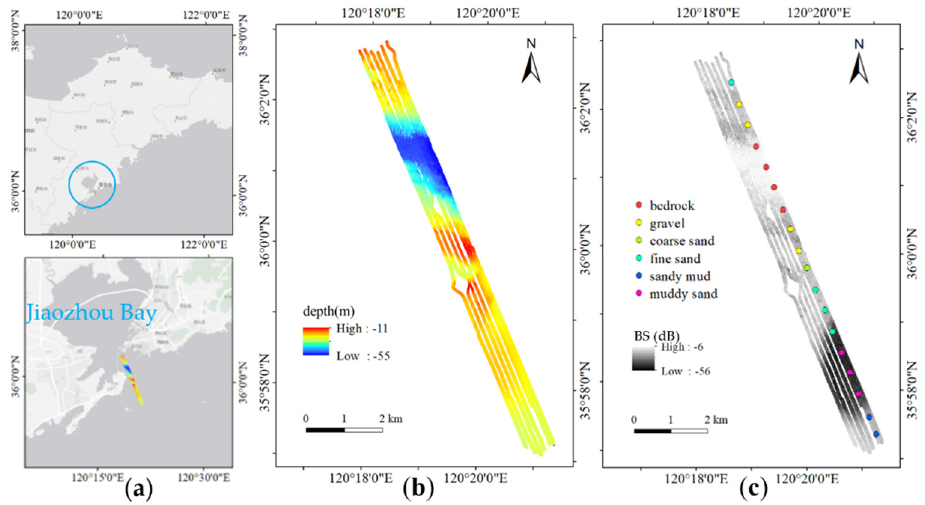
Figure5. ( a )Thelocationofthesurveyarea; ( b )seafloortopography; ( c Figure 5. ( a ) The location of the survey area; ( b ) seafloor topography ; ( c ) BS mosaic and sampling information.